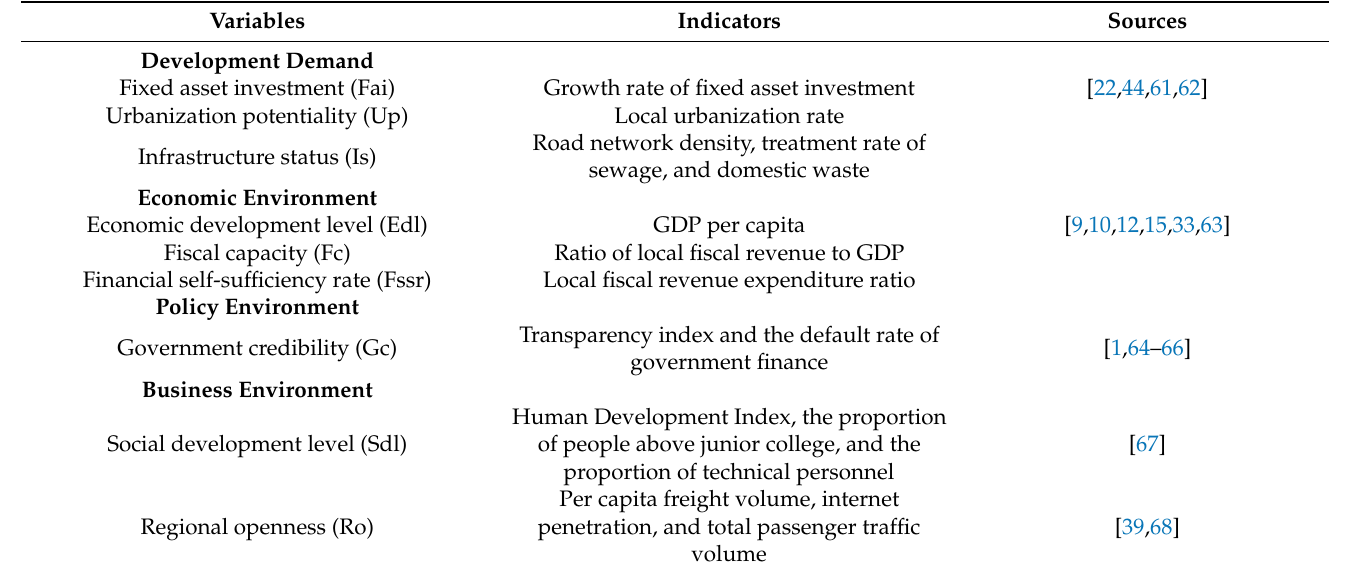
Table 1. Observed variable-related indicators (source: experts’